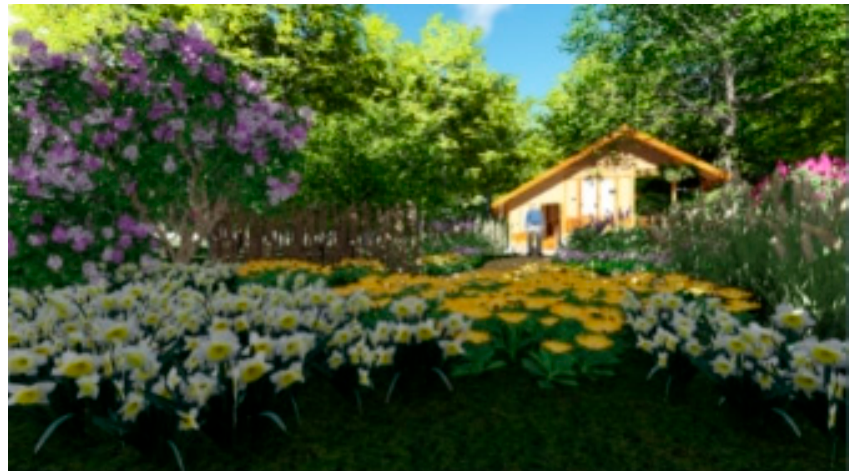
Figure 1. Example 1 of an experimental picture.